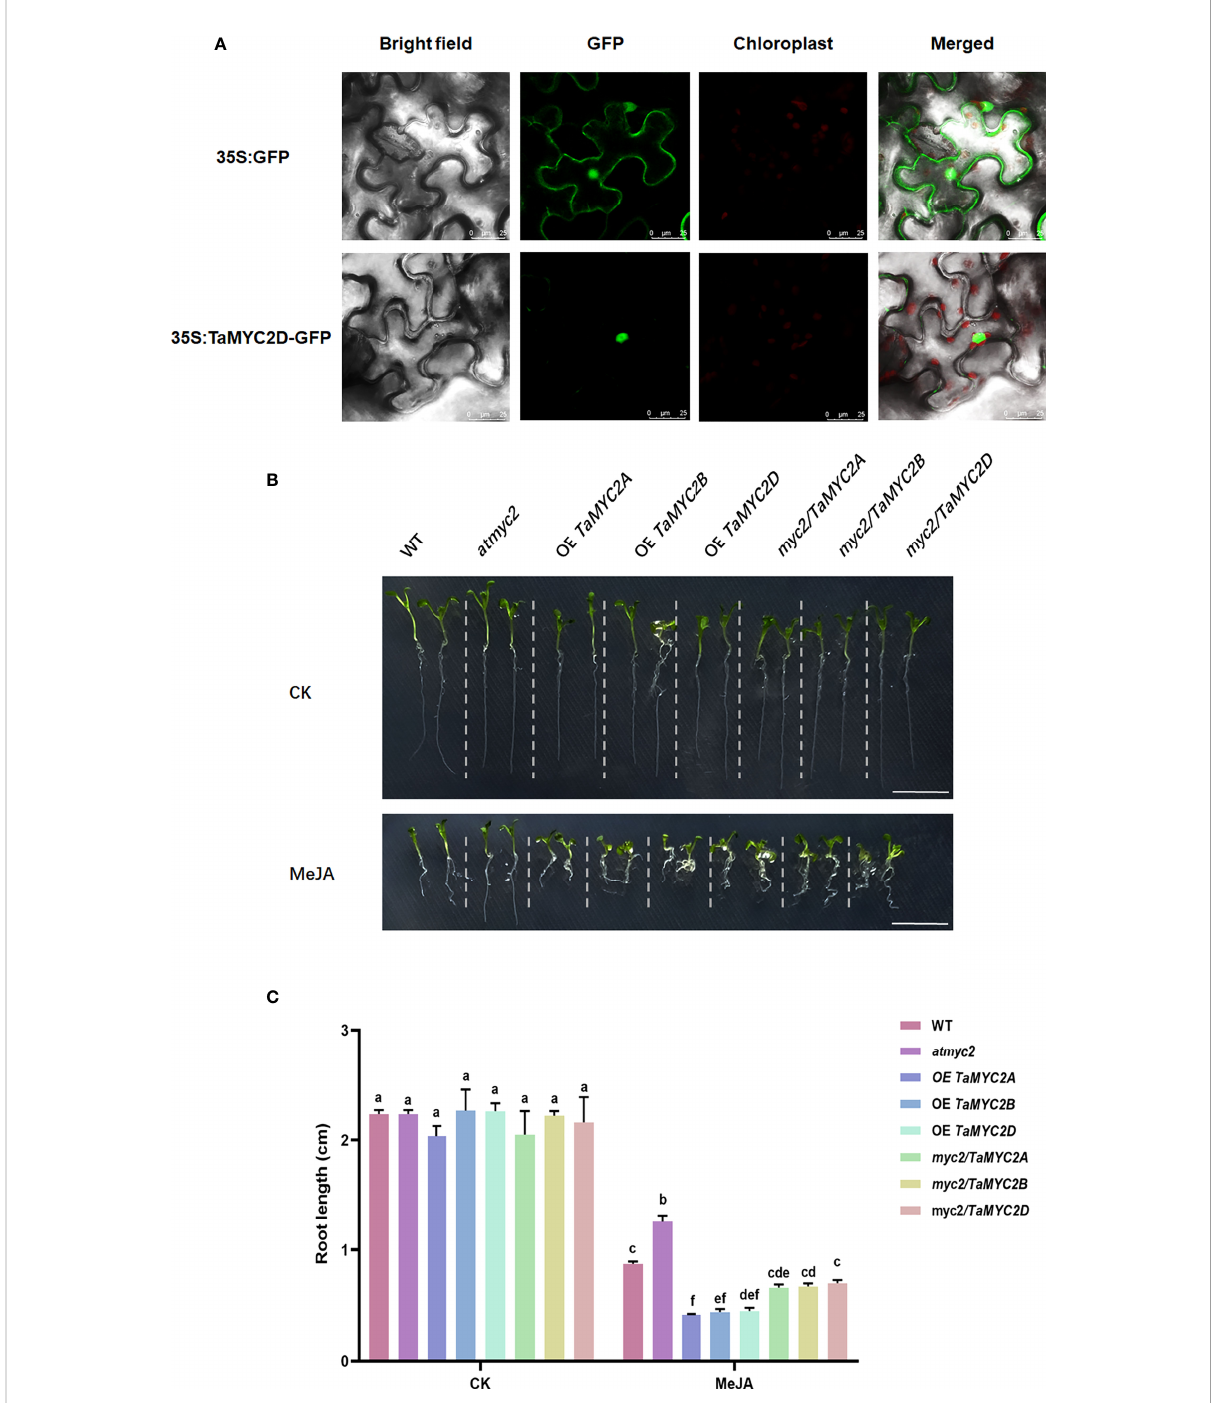
FIGURE 2 Subcellular localization of TaMYC2D in Nicotiana benthamiana and detection of JA sensitivity in TaMYC2A, B, D transgenic Arabidopsis root lengths. (A) Fluorescence detection of 35S: TaMYC2D-GFP fusion protein in tobacco leaves epidermal cells, and with 35S: GFP vector was used as a control (upper lane). (B) Root phenotype and (C) root length of Arabidopsis seedlings after 7 days of growth on medium with 50 m M MeJA treated and control groups. The top to bottom on the right side of each bar chart corresponds to the left to right at the same treatment. The error lines were obtained from three biological replicates. The mean values of the experimental data were analyzed by one-way ANOVA analysis. The comparison method was the least signi fi cant difference (LSD), and the bar graphs with different letters indicated signi fi cant differences ( p <